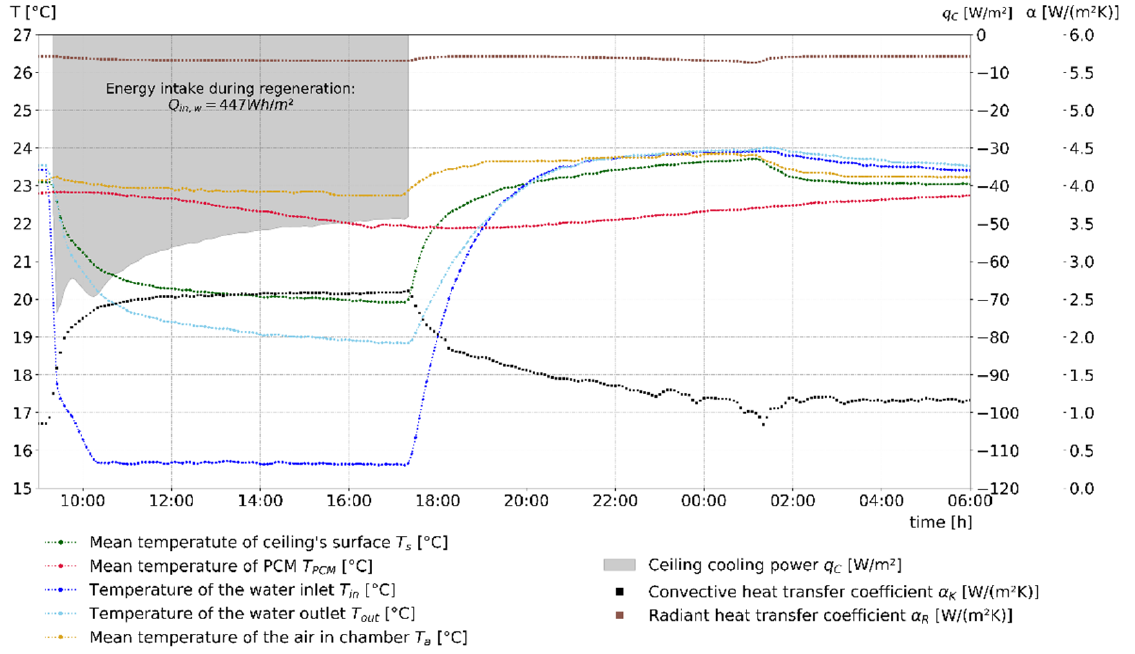
Figure 7. Experimental results for variant Ib.